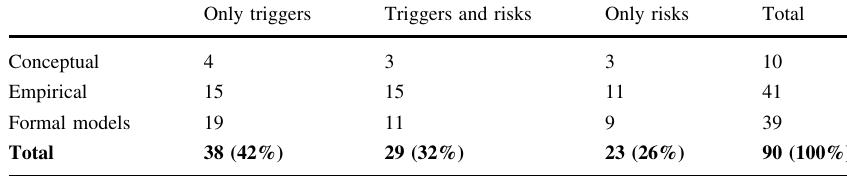
Table 11 Integration of stakeholder triggers and SSCM risks